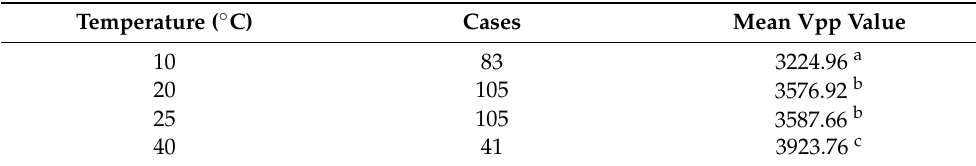
Table 17. Duncan’s Multiple Range Test for Temperature of Two-Way ANOVA results for the delay with selected data.